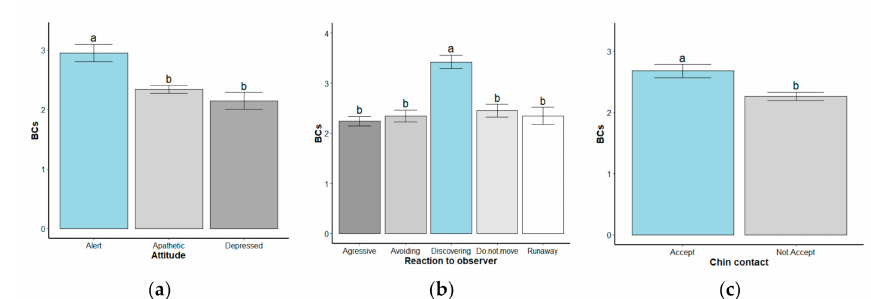
Figure 7. Error bars for the statuses of the behavior parameters: ( a ) the mean body condition of alert, apathetic, and depressed kiln donkeys, along with the mean ± standard error of the mean; ( b ) the mean body condition of donkeys that were aggressive and avoidant and that reacted to the observer by discovering, not moving, and running away, along with the mean ± standard error of the mean; ( c ) the mean body condition of donkeys who accepted and did not accept chin contact, along with the mean ± standard error of the mean. The bars labeled with di ff erent letters indicate a significant di ff erence based on the Tuckey’s test, p < 0.05, for attitude and response to observer, and the t -test for chin